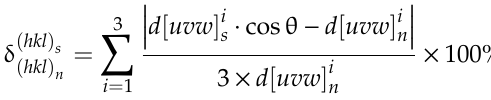
Table 2. Lattice constants of the studied phases.